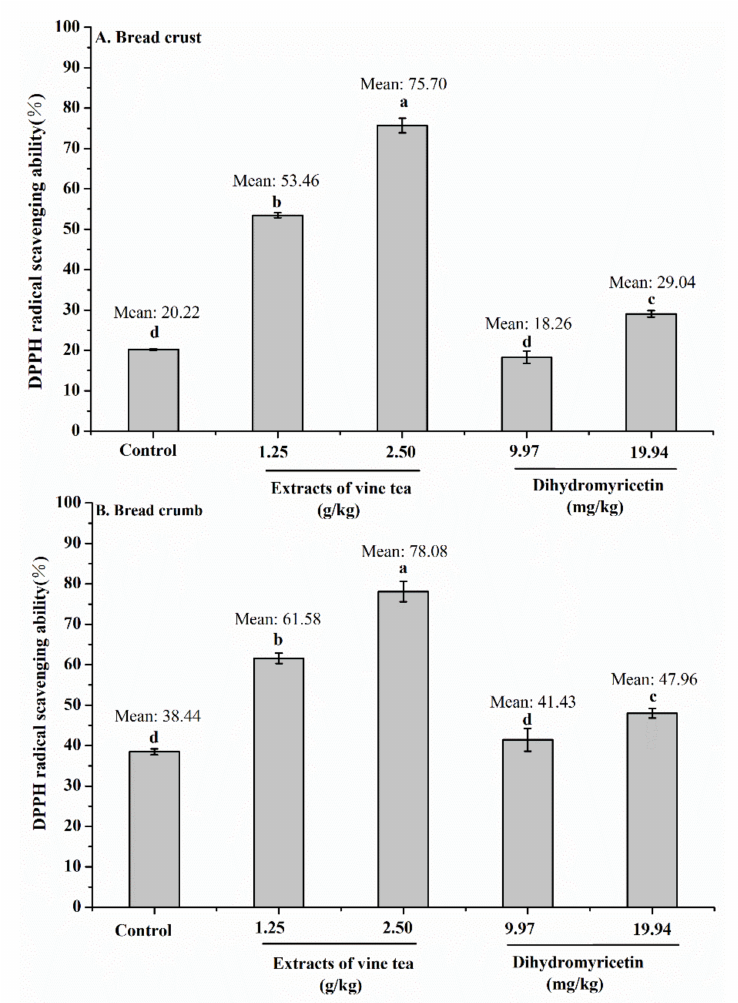
Figure 3. DPPH (2-diphenyl-1-picrylhydrazyl) radical scavenging abilities of the crust ( A ) and crumb ( B ) of the control bread (without supplement) and sample bread (vine tea extract or dihydromyricetin): The results are expressed as mean ± SD ( n = 3). Di ff erent letters indicate significant di ff erences ( p <